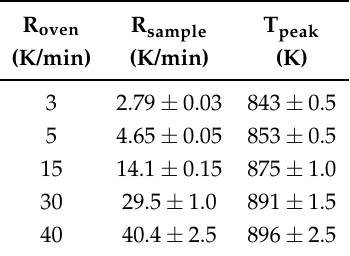
Table 1. Different temperature ramps used in the experiment. R oven is the nominal temperature ramp of the external oven, R sample is the corresponding measured temperature ramp of the sample at T peak . T peak is the measured sample temperature at which the maximum of the effusion peak occurs (see Figure